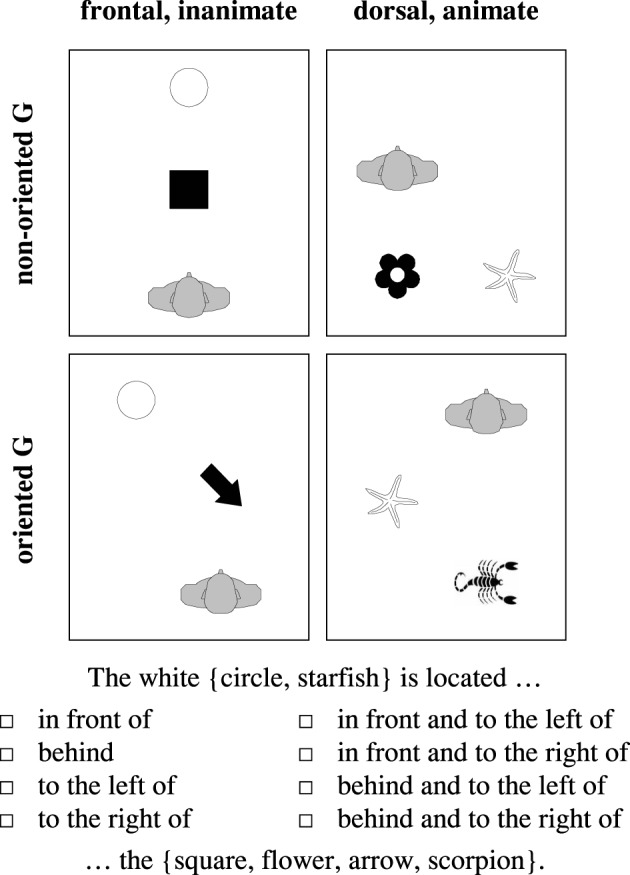
Four example items.